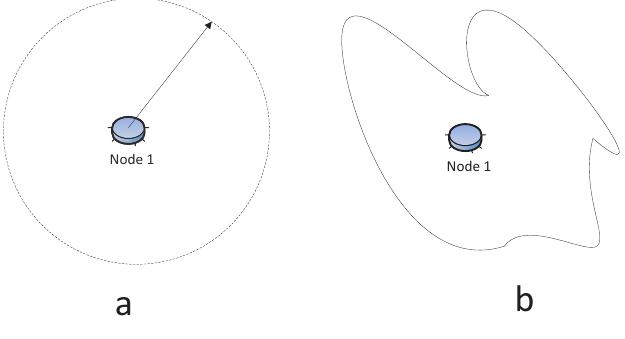
Figure 3. ( a ) Regular radio model; ( b ) Irregular radio